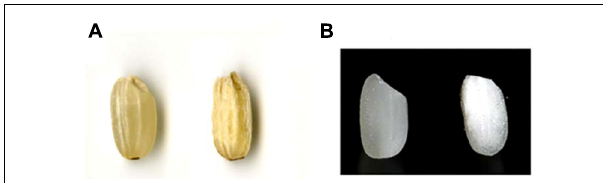
FIGURE 1 | Seed morphology of representative grain samples harboring hp-SSIIa construct compared with the control. (A) Unpolished grain of a negative segregant (left) compared with hp-SSIIa-shr line (SS28), showing shrunken seed phenotype. (B) Polished grain of a negative segregant (left) compared with an hp-SSIIa-op line (SS5), showing opaque phenotype.